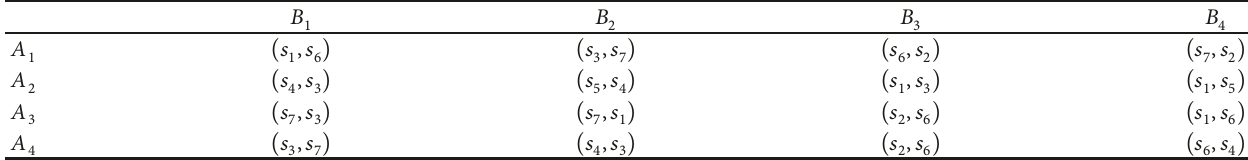
Table 1: The linguistic Pythagorean fuzzy preference information matrix 𝐿 1 provided by the decision-maker 𝑀 1 .